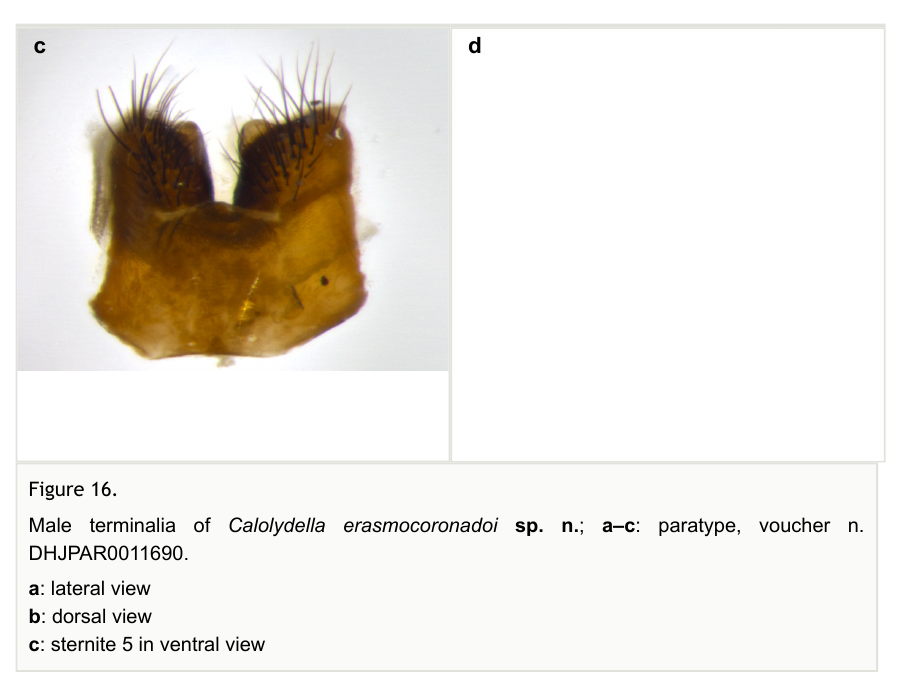
Female (Fig. 15d, e, f). Length: 4–7mm. Fronto-orbital plate 2.5X as wide as in male. Diagnosis Calolydella erasmocoronadoi can be distinguished from all other species of Calolydella by the following combination of traits: fronto-orbital plate bare, up to 50% silver pollinose, thoracic vittae visible only under certain angles of light, anatergite with three or more setae arranged in a small tuft, wing vein R with 6–7 setulae, and abdomen with uninterrupted transverse marginal pollinose bands.